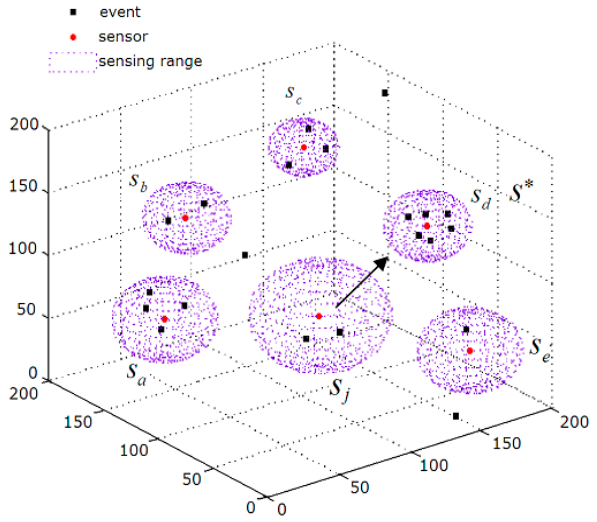
s moves toward s ∗ (the red points are sensors; the purple spheres represent the j sensing space (coverage) of sensors; black dots are